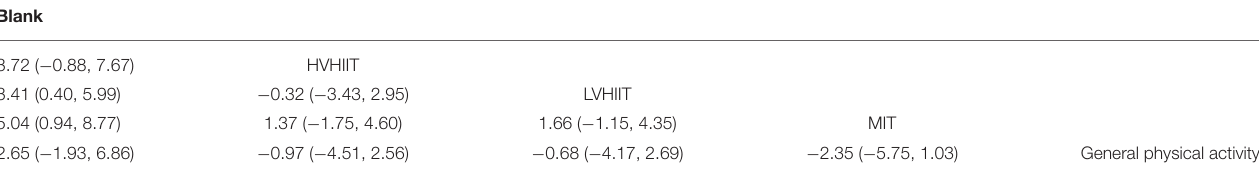
TABLE 3 | The league table of the interventions for diastolic blood pressure (DBP).